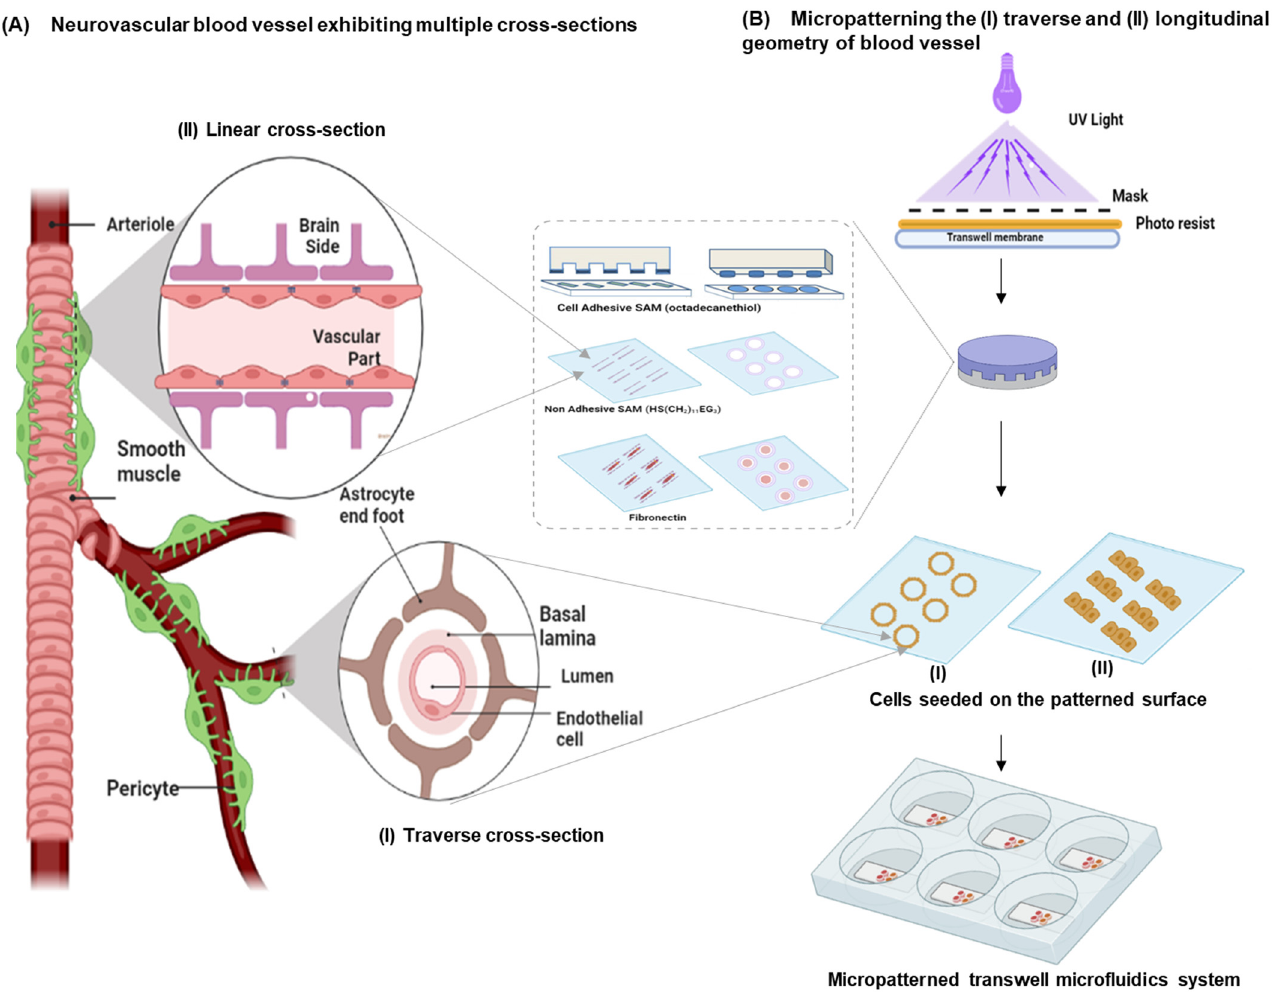
Figure 1. Microprinting of blood vessel architecture on a transwell: ( A ) blood vessel indicating a linear (longitudinal) geometry from the side view and a traverse (ring) geometry from a top view of the neurovascular unit; ( B ) micropatterning by microcontact printing with a cell-adhesive monolayer representing the side view of a traverse and a longitudinal cross-section of the blood vessel. A negative photoresist model was made with UV light through a mask containing the desired micropatterns as ring and linear geometries. PDMS elastomeric stamps were cast with prepolymers and a curing agent on the mold. Cell-adhesive octadecanethiol, a self-assembling monolayer (SAM), was transferred onto the transwell membrane and further subjected to nonadhesive ethylene glycol terminated SAM and fibronectin.